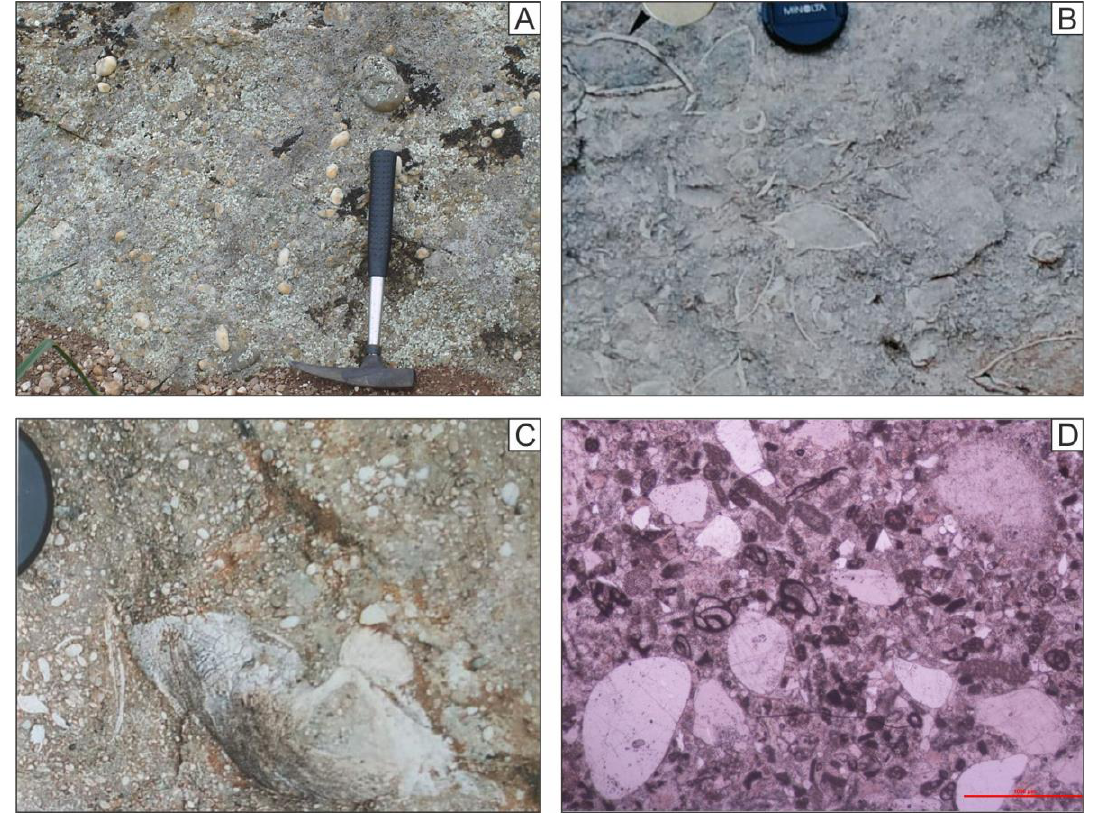
Figure 9. Site 5: The Lower Oligocene As Fm in the Malvariche Valley. ( A ) Field outcrop of the As Fm. ( B ) Detail of the fossils (bivalves) from the As Fm. ( C ) Detail of the rounded quartzite pebbles and bivalves from the As Fm. ( D ) Thin section of the As Fm: calcarenites with benthonic foraminifera and rounded quartz pebbles.